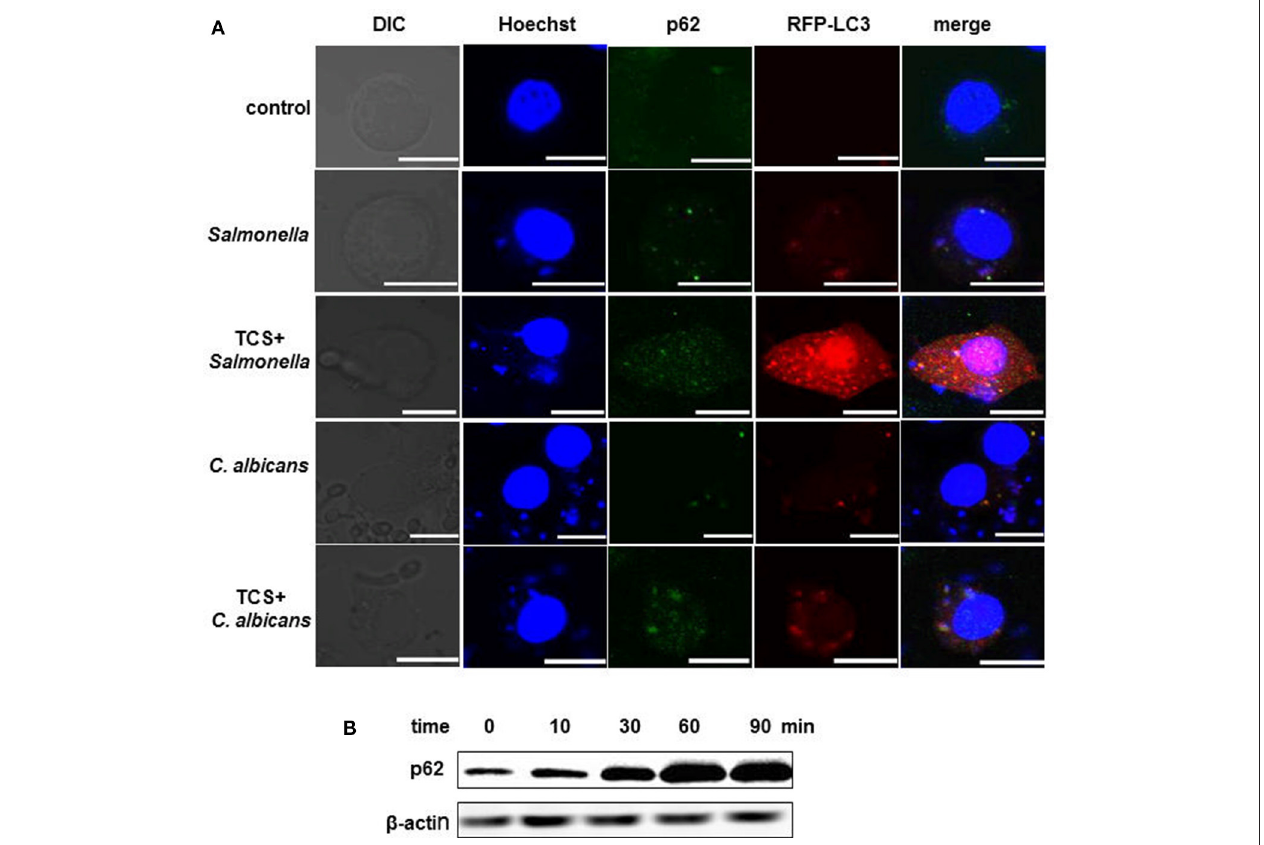
FIGURE 2 | TCS improves p62 expression and strengthens the co-localization among intracellular pathogens, LC3 and p62. RAW264.7 cells were transfected with RFP-LC3 plasmids and incubated with or without pathogens for 30min, and then the cells were treated with or without TCS (8 µ M) for 90min, followed by immunofluorescent staining. p62 was marked by a p62 antibody, and the pathogens and nuclei were stained by Hoechst 33342. The results were collected by a laser-scanning confocal microscope (A) . Scale bars = 10 µ m. The cells were treated with TCS (8 µ M) for different times ranging from 0 to 90min, and the levels of p62 were assayed by western blot (B) . Compared to the respective